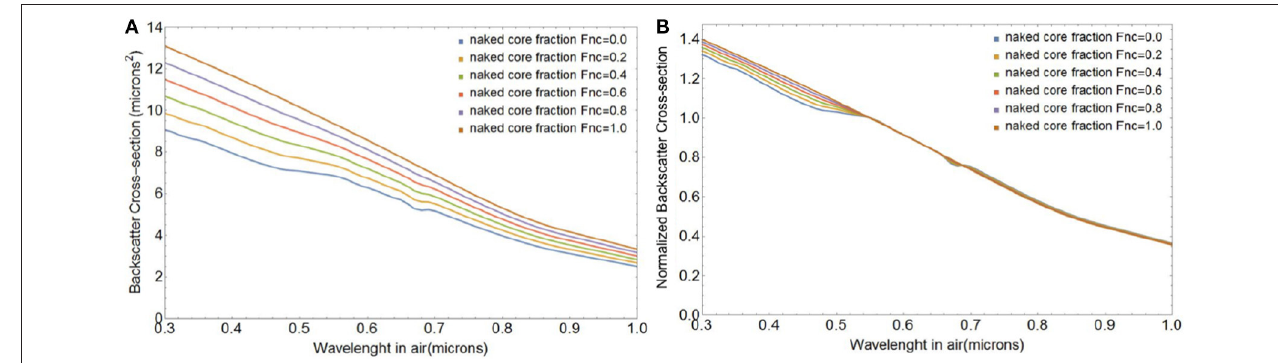
FIGURE 7 | Changes in the total spectral backscattering cross-section σ bbtot magnitude (A) and spectral shape (B) as a coccolithophore with a core radius r c of 3.7 µ m, a lith semi-major axis a 0 of 1.7 µ m, and 4 layers of liths sheds its liths.